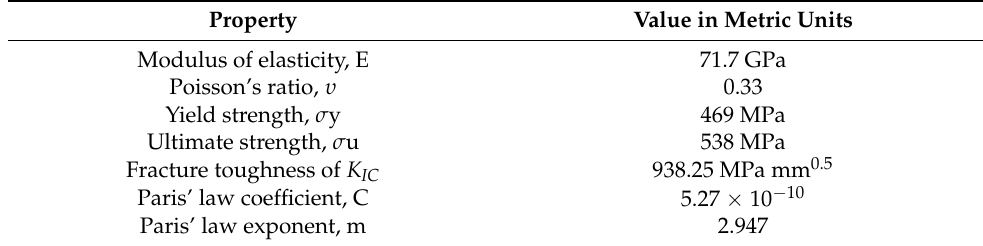
Figure 10. ( a ) Description geometry of the cracked plate with three holes (dimensions in mm); ( b ) initial mesh. Table 2. Materials properties for aluminum